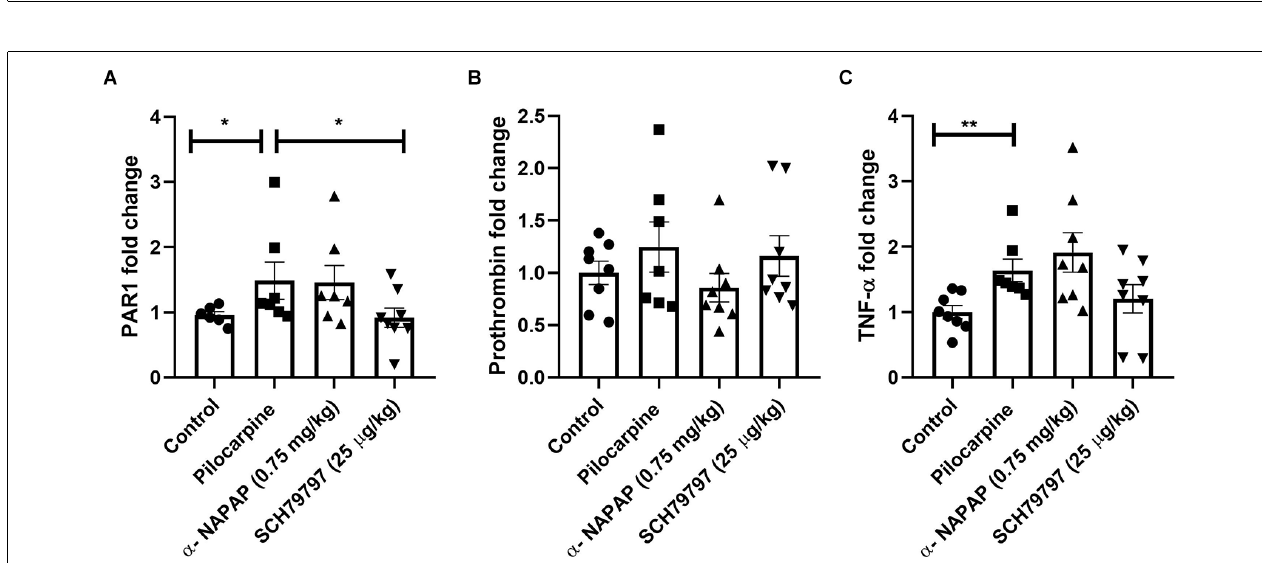
stimulations, EPSP values in the pilocarpine-induced SE mice were 1.32 ± 0.105 compared to 1.83 ± 0.051 (controls) and to 1.81 ± 0.056 (vehicle-treated animals, Figure 1A ; F (2, 21) = 14.9; p < 0.001). Strikingly, the thrombin inhibitor, α -NAPAP injected